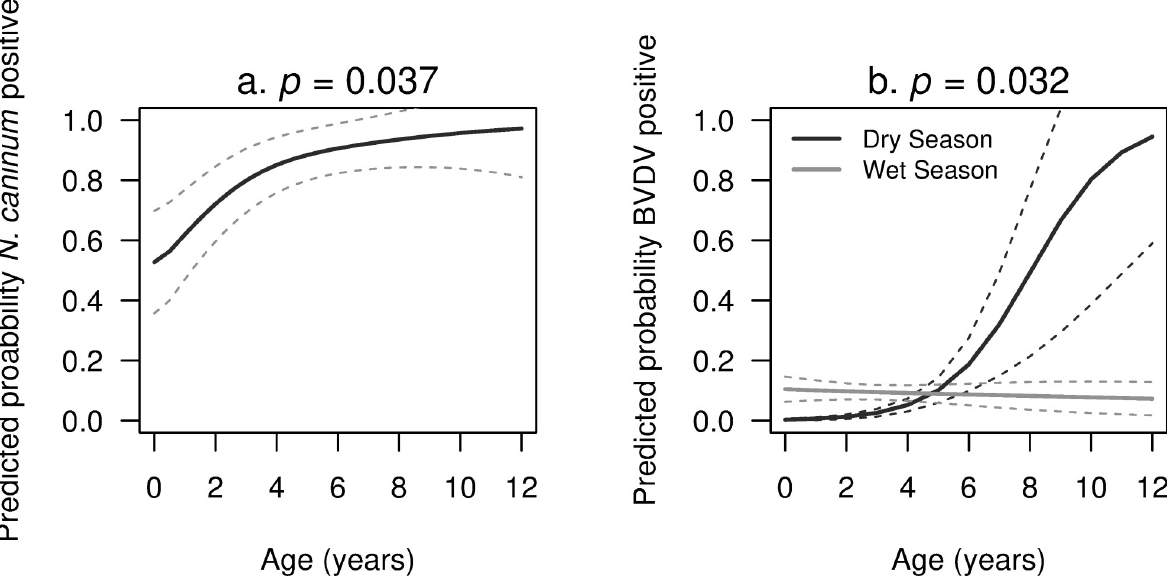
Fig 6. The effect of significant predictors from final multivariable logistic models on the probability that large ruminants were seropositive to infectious pathogens from 2016–2018, Lao PDR. (a) Buffalo age on the probability of being Neospora caninum seropositive. (b) The interaction between age and season on the probability of cattle being Bovine Viral Diarrhoea Virus (BVDV) seropositive.